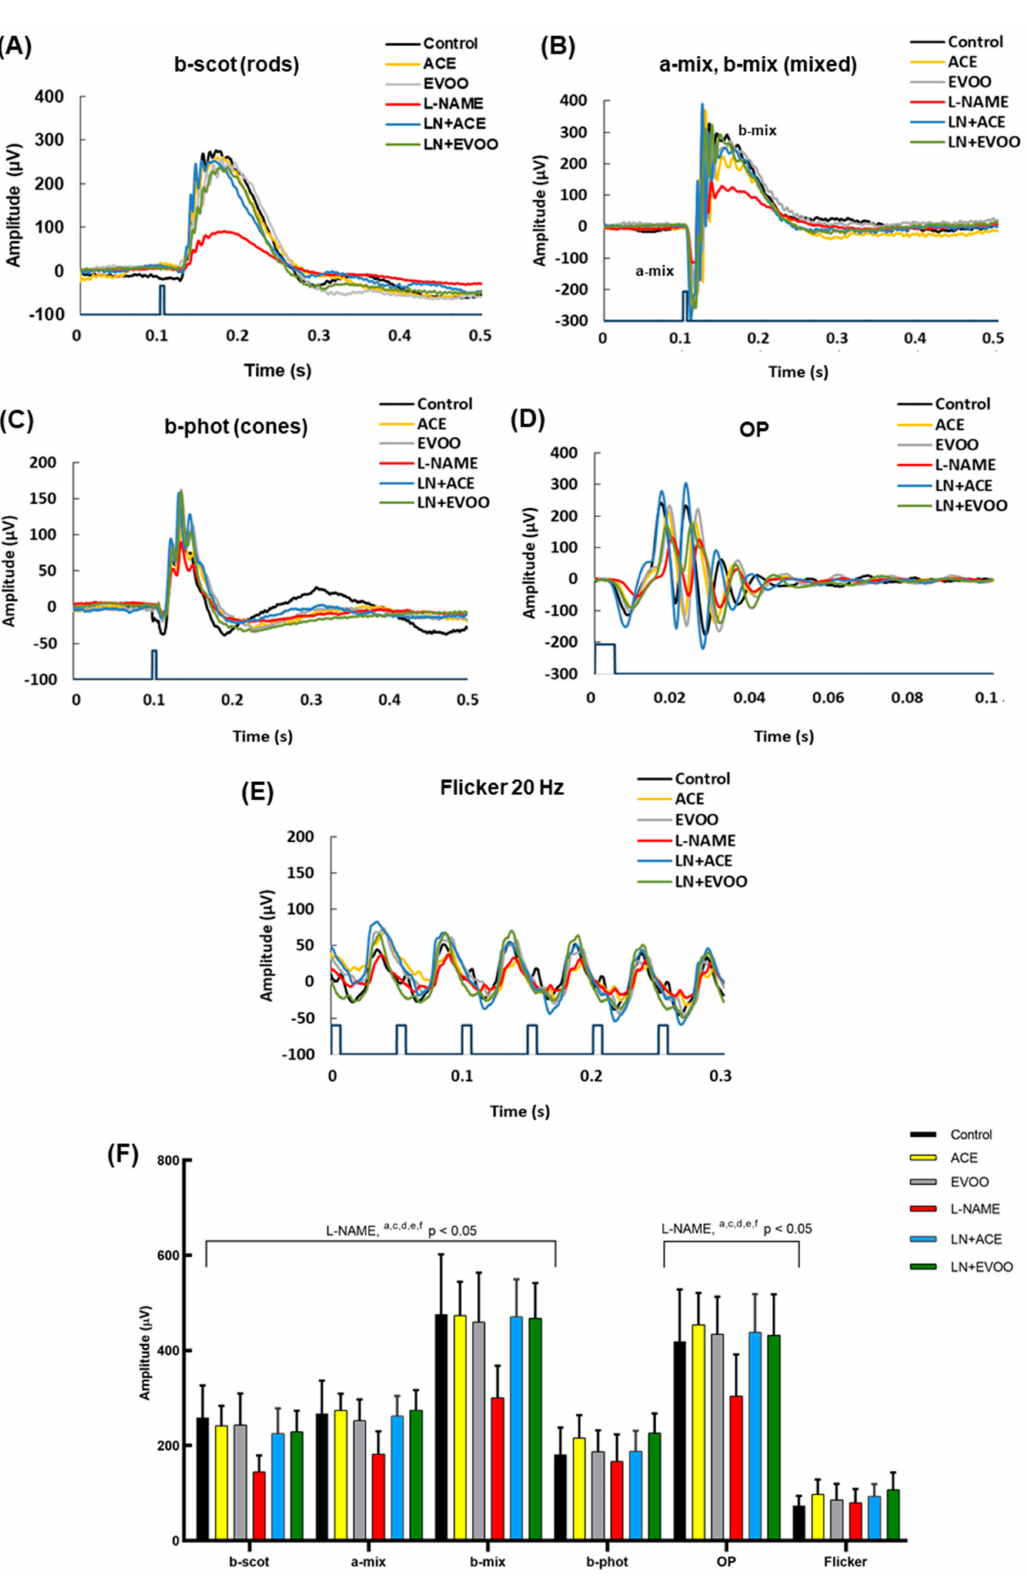
Figure 2. Electroretinogram (ERG) responses. Waveforms of representative ERG recordings: ( A ) b-scot (rods), ( B ) a-mix, b-mix (mixed), ( C ) b-phot (cones), ( D ) oscillatory potentials (OP) and ( E ) flickers of each experimental group are represented. ( F ) Mean amplitude of all waves from the different experimental groups. Values are expressed as mean ± SEM of ten animals per group: a p < 0.05 vs. Control; c p < 0.05 vs. EVOO; d p < 0.05 vs. LN + EVOO; e p < 0.05 vs. ACE; f p < 0.05 vs. LN +